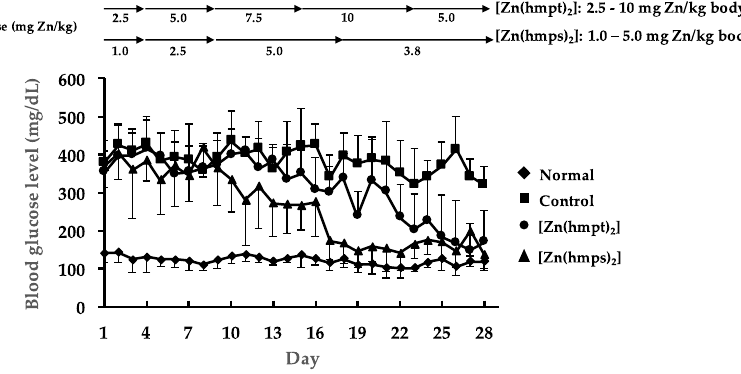
Figure 2. Changes in the daily blood glucose levels over 28 days in normal, control